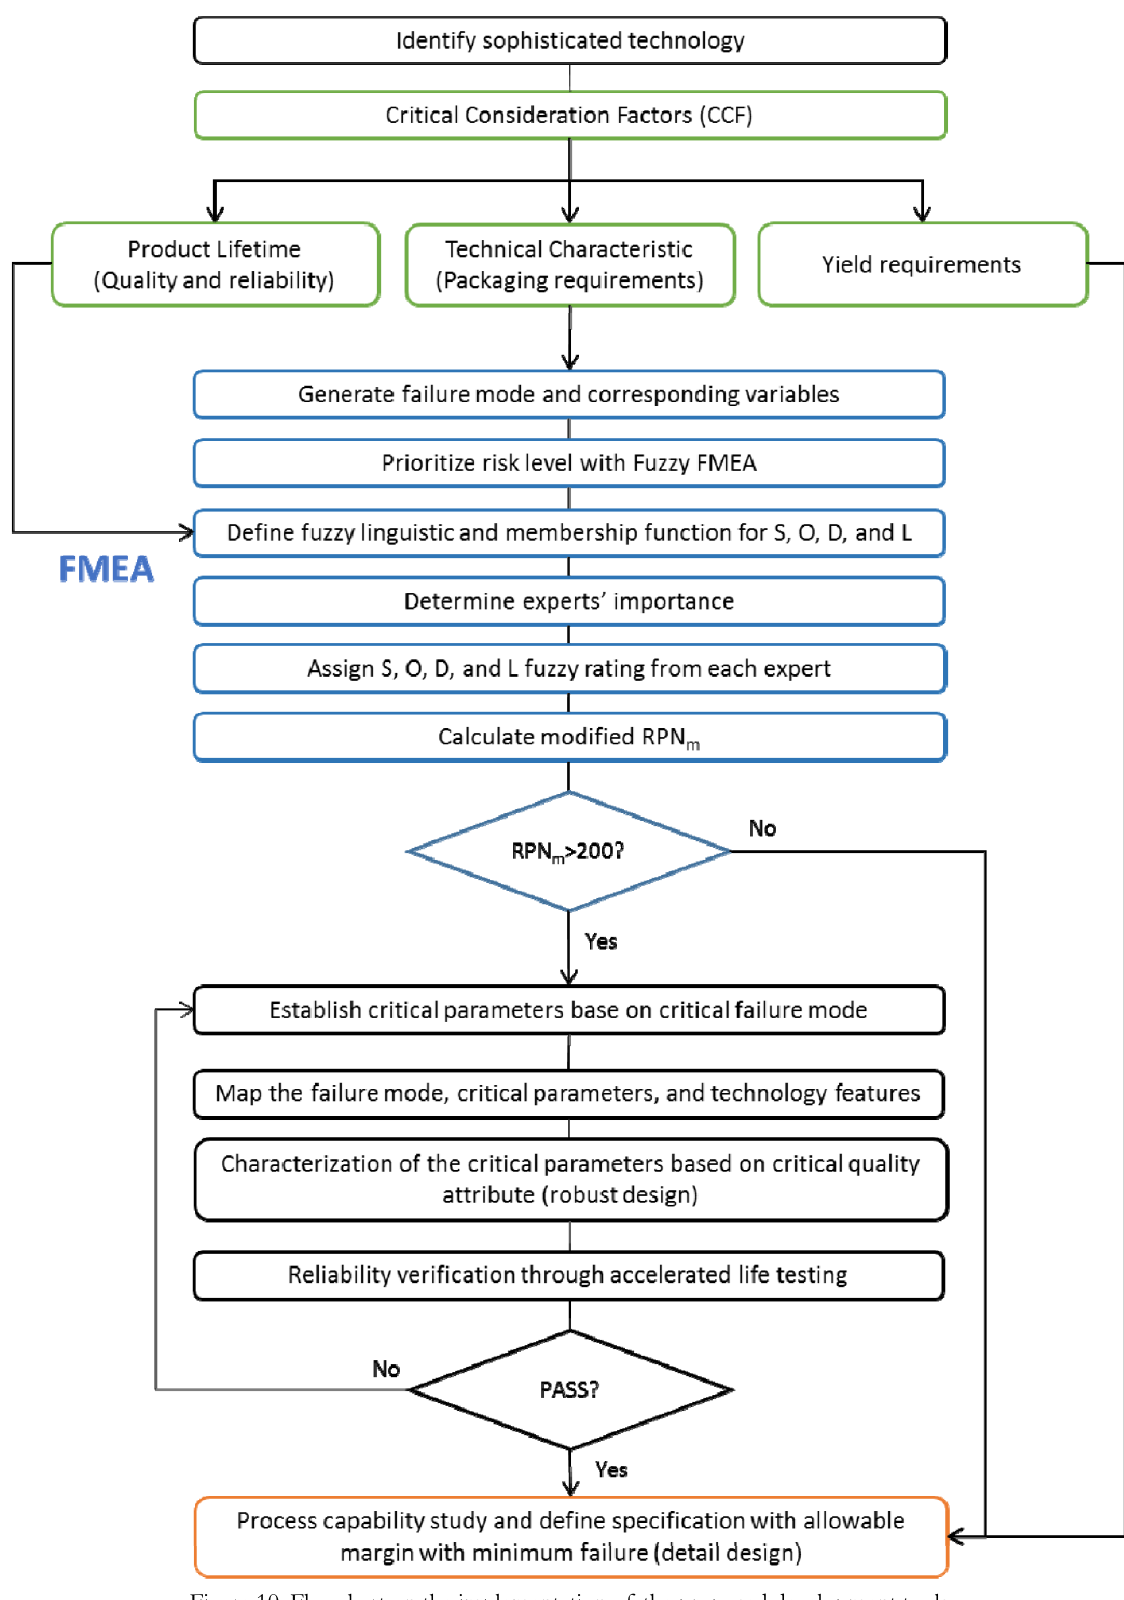
Figure 10. Flowchart on the implementation of the proposed development